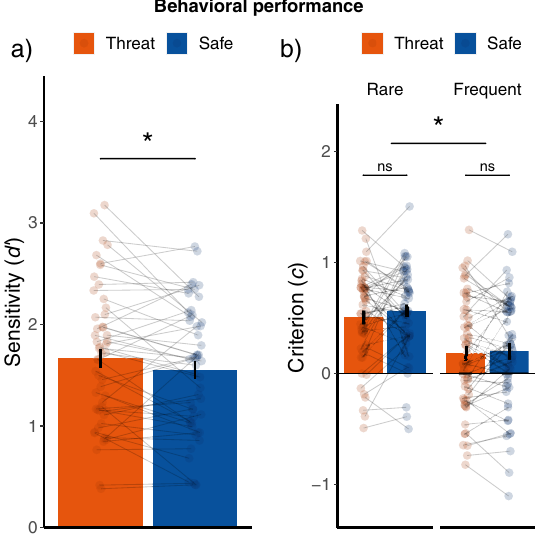
Figure 3. ( a ) Increased sensitivity (d’) under threat-of-shock ( b ) no interaction between threat-of-shock manipulation and the target-frequency manipulation on the decision criterion. Error bars represent + /− standard error of the mean